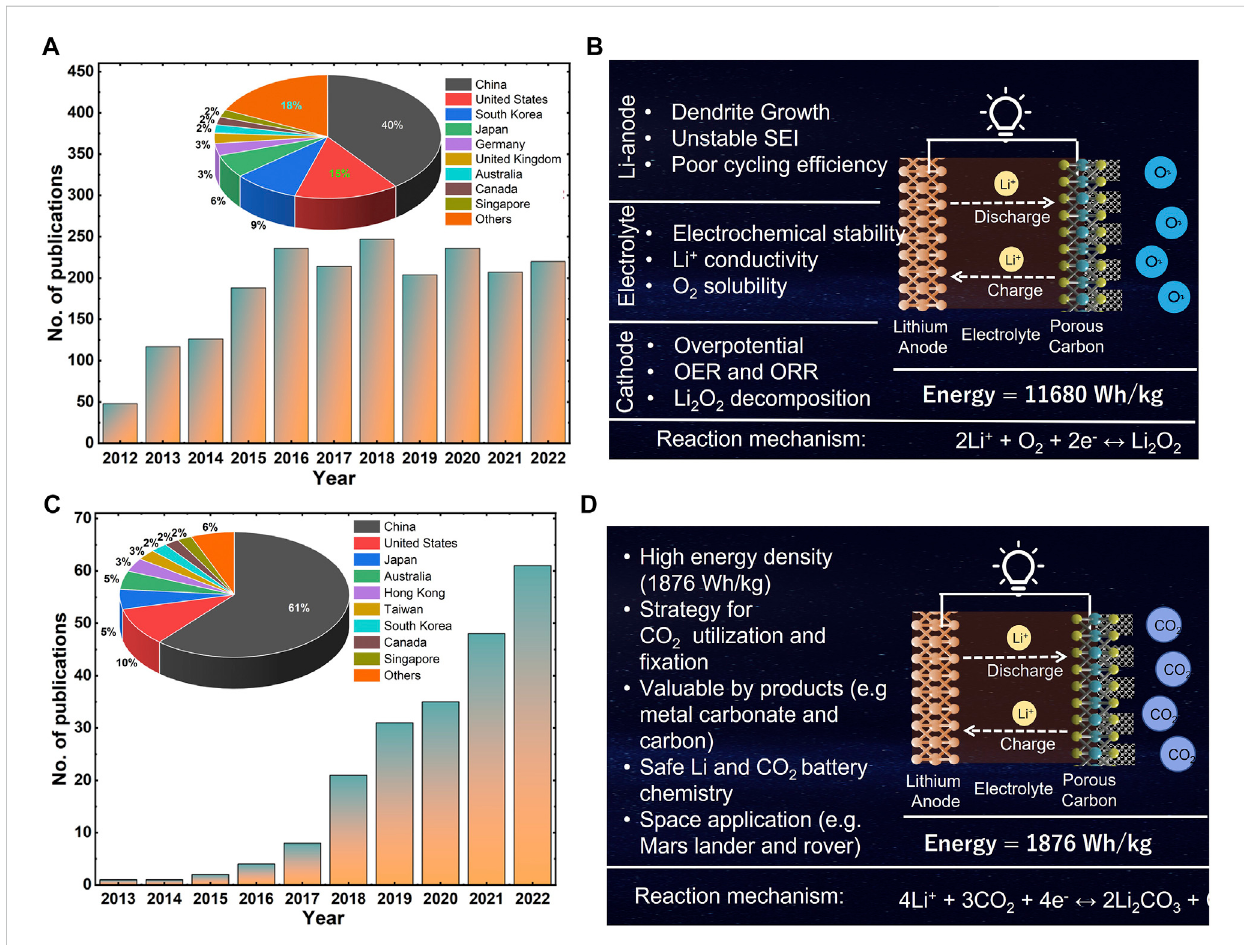
FIGURE 1 (A) . Year-wise publication of Li-O 2 battery research (data were collected from web Scopus search), (B) . Challenges and schematic of Li-O 2 battery, (C) . Year-wise publication of Li-CO 2 battery research (data were collected from web Scopus search), (D) . Advantage and schematic of Li-CO 2 battery, reported in the